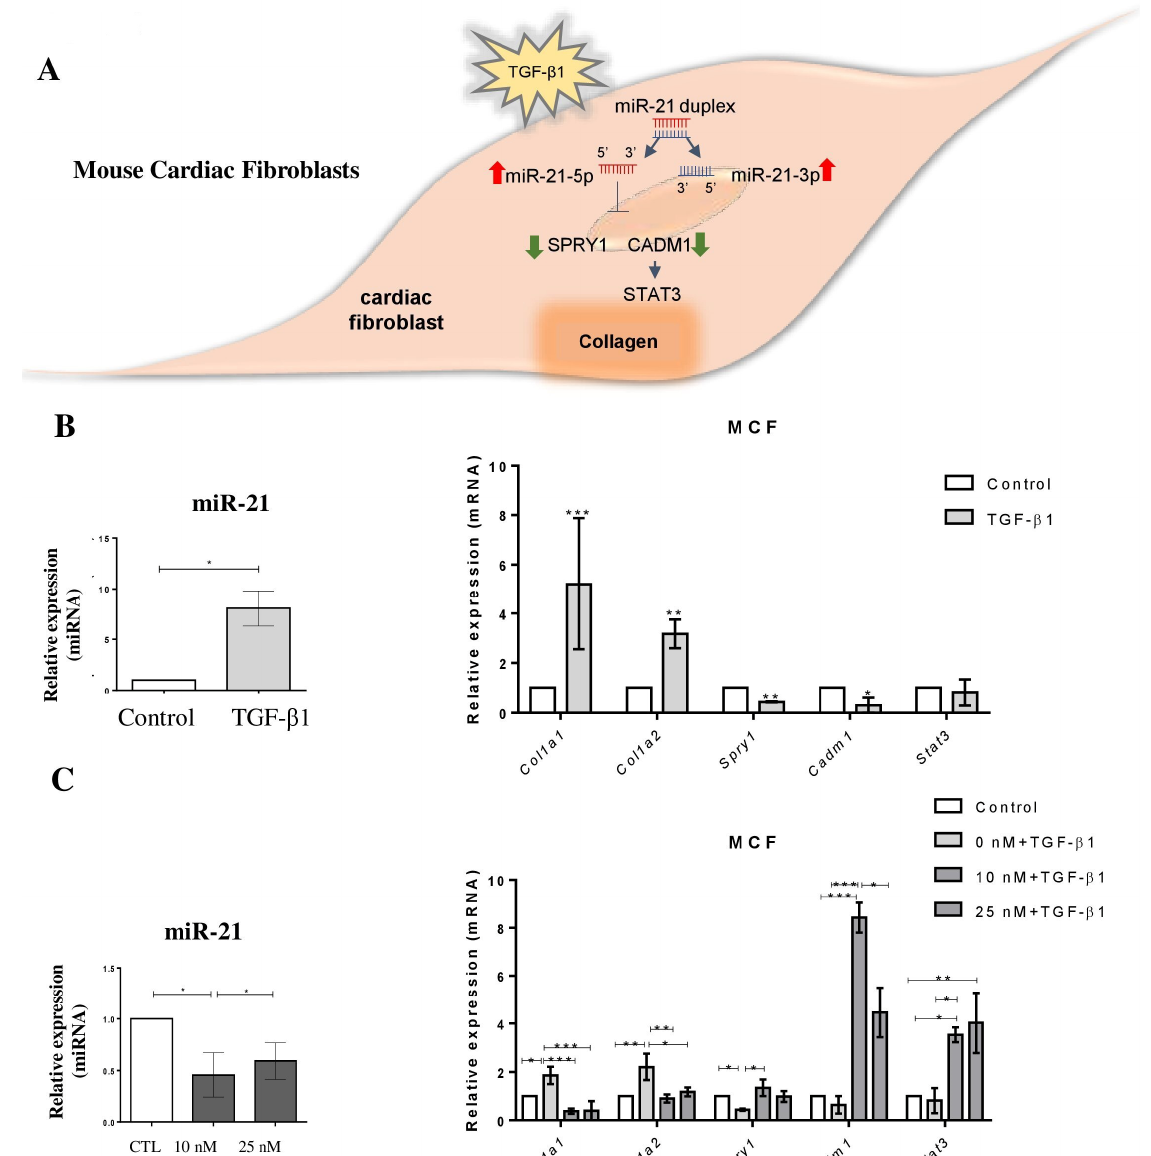
Figure 4. Interplay of TGF- β signaling and miR-21 in mouse cardiac fibroblasts. ( A ) Scheme showing the TGF β pathway in cardiac fibroblasts. ( B ) Increased expression of miR- 21, Col1a1 , Col1a2 , Spry1, and Cadm1 in mouse cardiac fibroblasts, 24 h after stimulation with TGF- β 1. ( C ) Expression of miR-21 and mRNA expression after stimulation with TGF- β 1 and treatment with LNA-anti-miR-21, measured by RT-qPCR (fold change to non-stimulated control). miRNA expression levels were normalized to miR-423-3p, and mRNAs were normalized to HPRT/GAPDH . Results are expressed as mean ± SEM of three independent experiments. * p < 0.05, ** p < 0.01, *** p < 0.001, Student’s t -test.